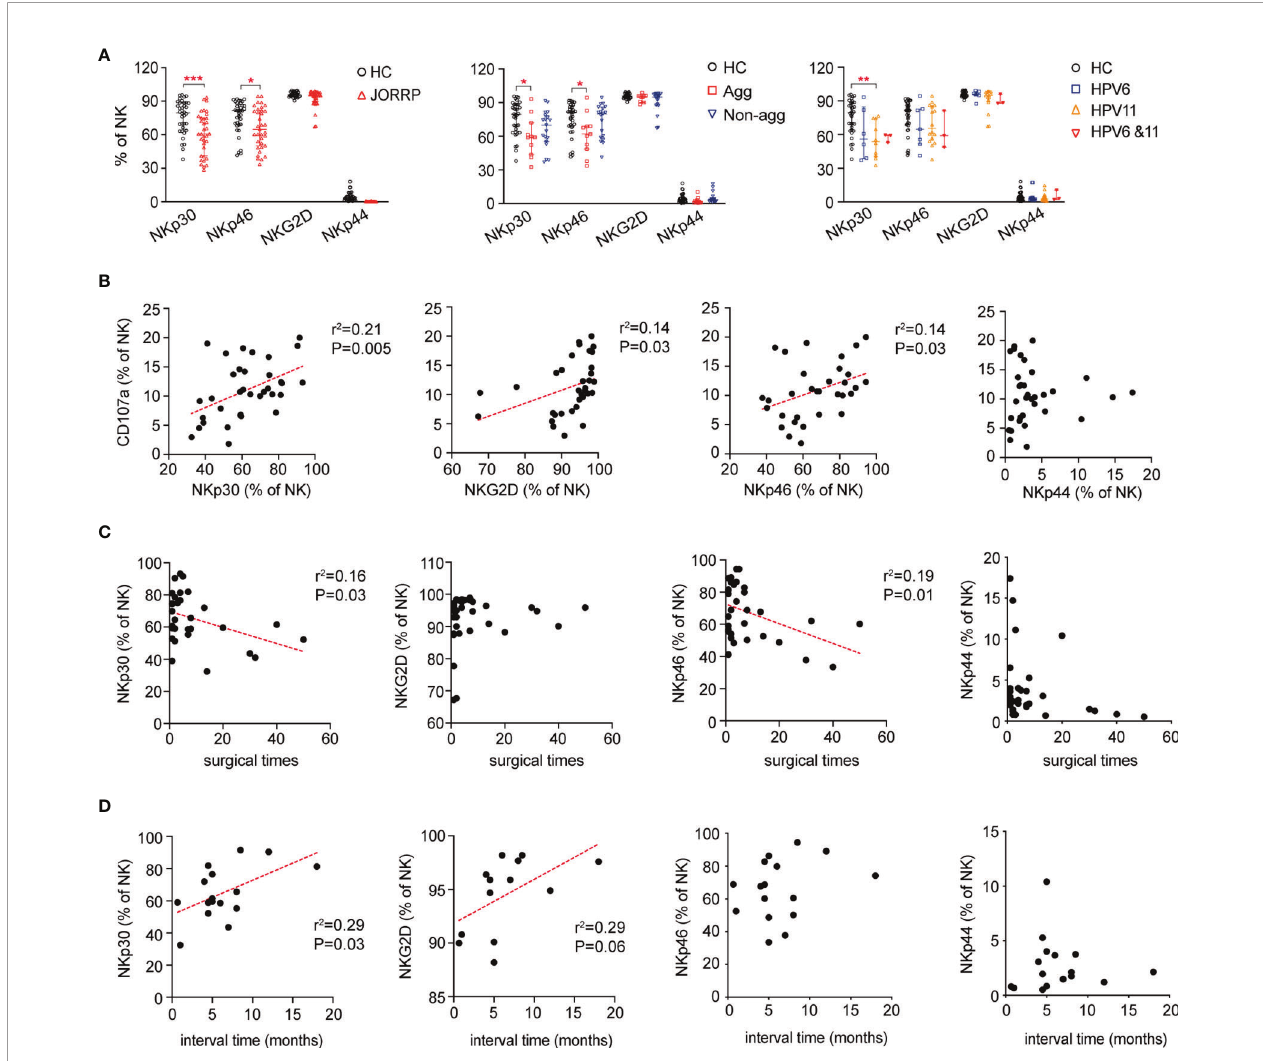
FIGURE 3 | Decreased expression of NK cell-activating receptors on NK cells in JORRP patients. (A) Percentage analysis of NKp30, NKp46, NKG2D, and NKp44 expression on NK cells as determined by fl ow cytometry of HCs (n = 35) and JORRP patients (n = 35) or different subgroups of JORRP patients. Agg, aggressive (n = 11); Non-agg, non-aggressive (n = 19); 6, HPV6 (n = 14); 11, HPV11 (n = 16); 6&11, HPV6&HPV11 (n = 3). (B) Correlation of CD107a expression on NK cells with NKp30, NKp46, NKG2D, and NKp44 expression on NK cells. Spearman ’ s correlation coef fi cients are shown. (C) Correlation of NKp30, NKp46, NKG2D, and NKp44 expression on NK cells with surgical times. Spearman ’ s correlation coef fi cients are shown. (D) Correlation of NKp30, NKp46, NKG2D, and NKp44 expression on NK cells with interval time of surgical reoccurrence. Spearman ’ s correlation coef fi cients are shown. Data are presented as median with interquartile range. Each dot represents a single patient. ns, not signi fi cant; *P < 0.05; **P < 0.01; ***P <